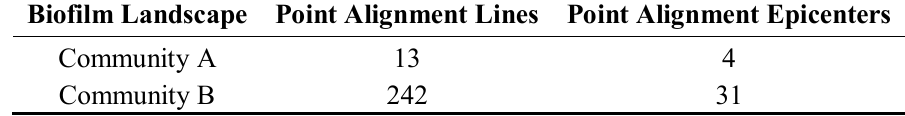
Table 7. Intensity of the line segment patterns indicating clustered bacterial interactions in Figure 8a,b.